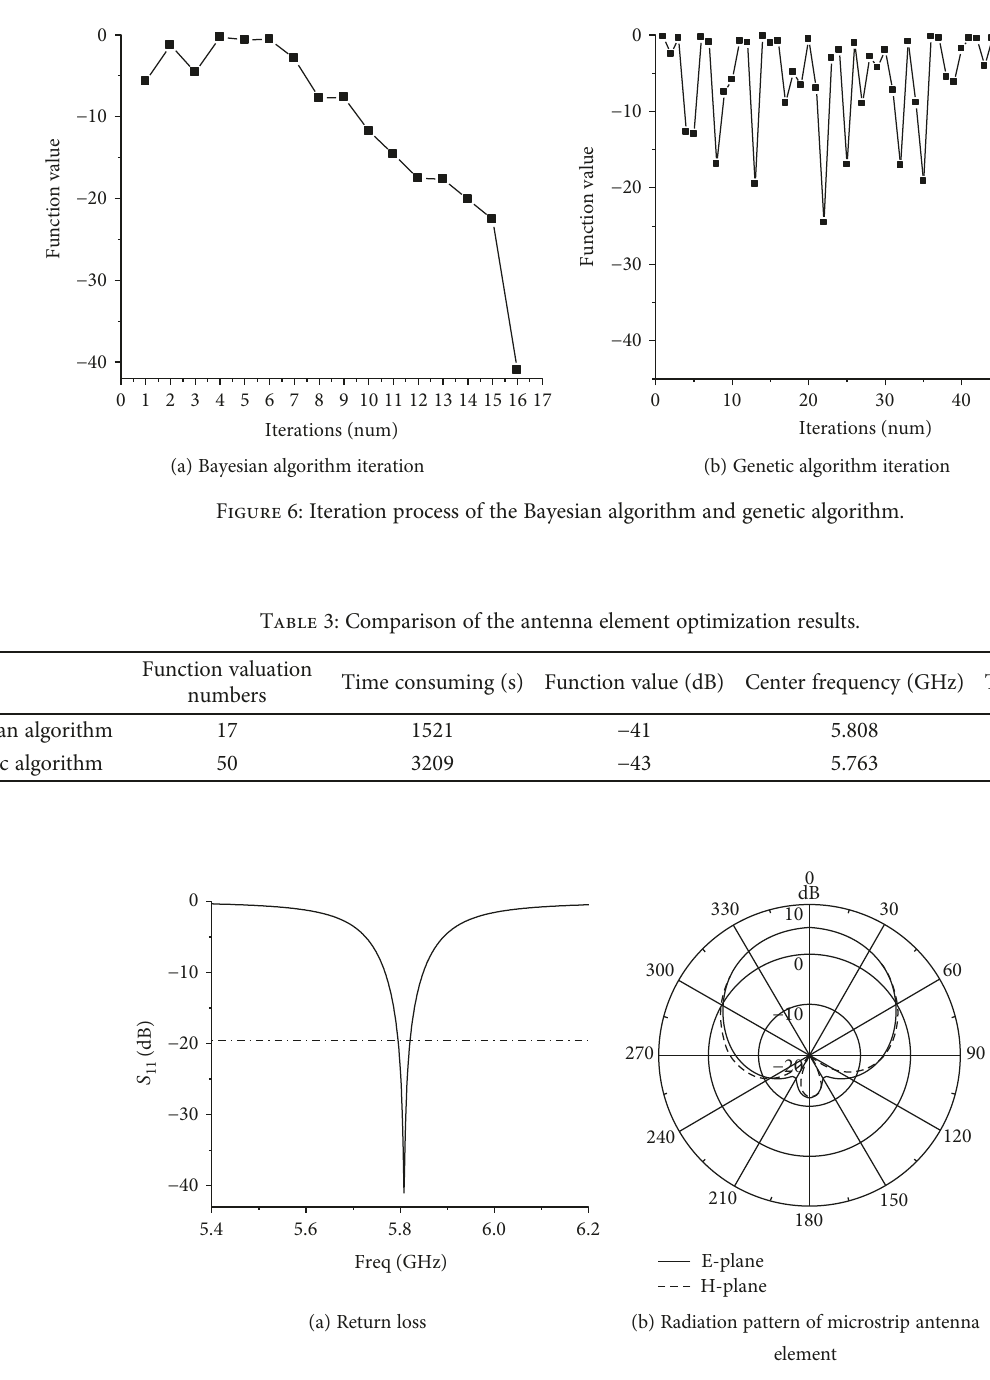
Figure 7: Simulated return loss and radiation pattern of the radiating